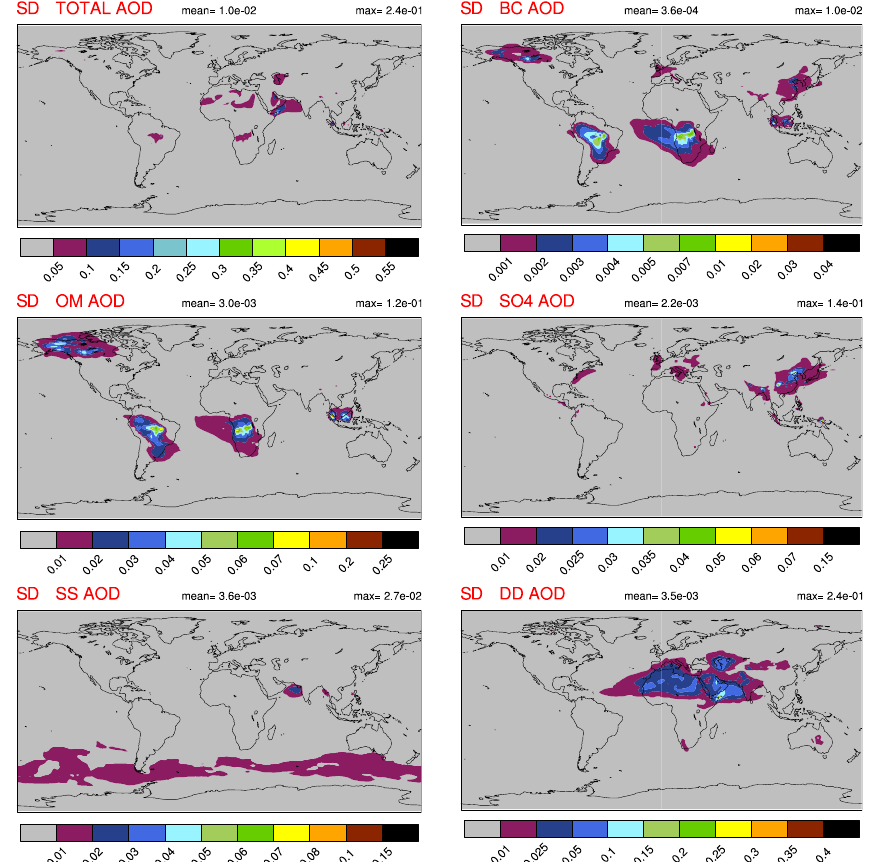
Figure 2. Mean standard deviation for JJA for the FreSimd2 simulation, as a representation of the ARPEGE-Climat internal variability, of the total, BC, OM, sulfate, SS, and DD AODs. Colour scales are the same as in Figs. 5 and 7.